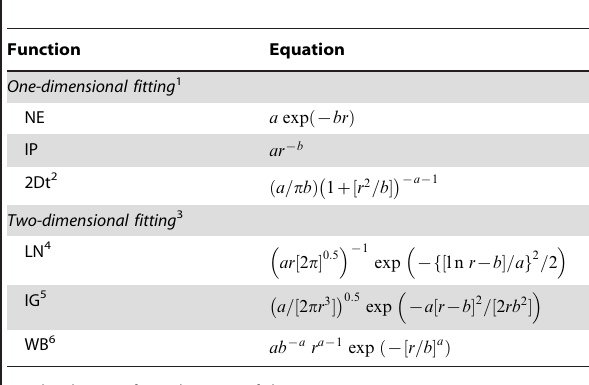
Table 1. Empirical models tested for mahogany ( Swietenia macrophylla ) seed dispersal expressed in one dimension and two dimensions downwind of 25 isolated trees at the Marajoara forest in Para´,